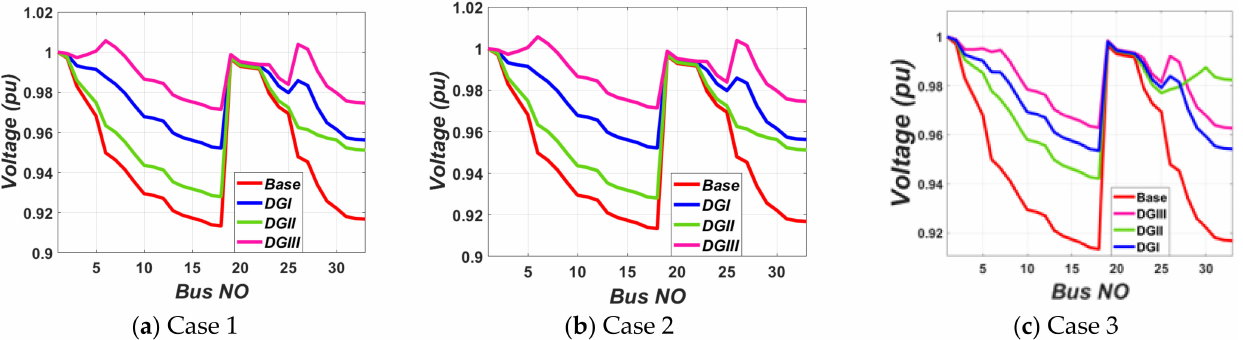
Figure 15. Voltage profile for IEEE 33-bus test